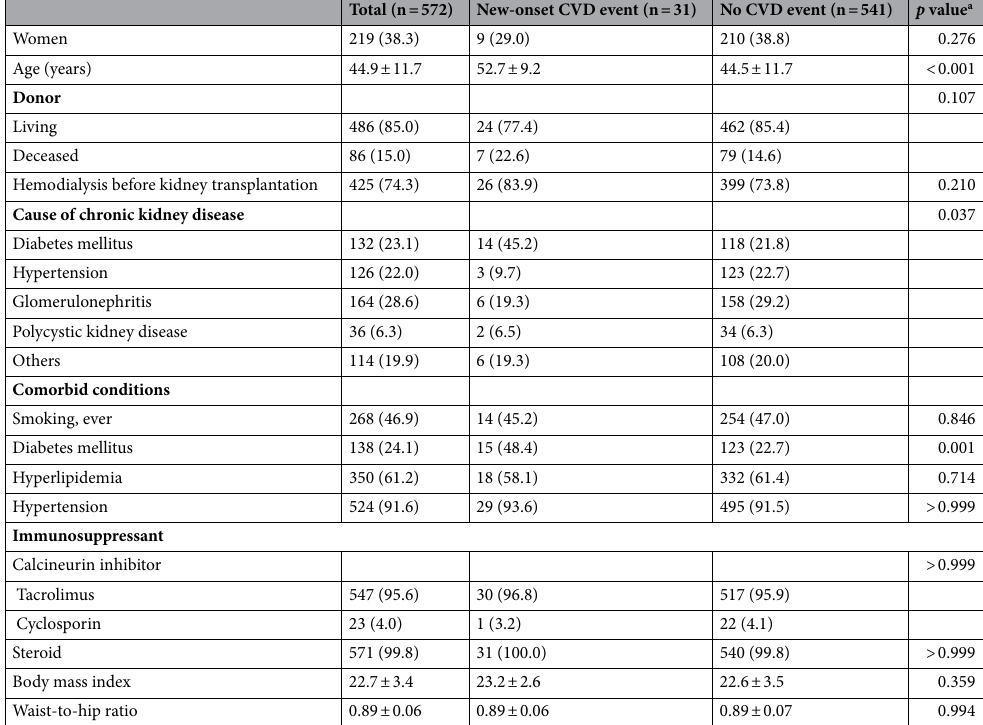
Table 1. Baseline characteristics of the study patients before kidney transplantation. Values are provided as n (%) or mean ± standard deviation. CVD includes coronary artery disease, cerebrovascular disease, and peripheral arterial disease. a p value from the chi-square test, Fisher’s exact test, or Student’s t-test, performed as appropriate.